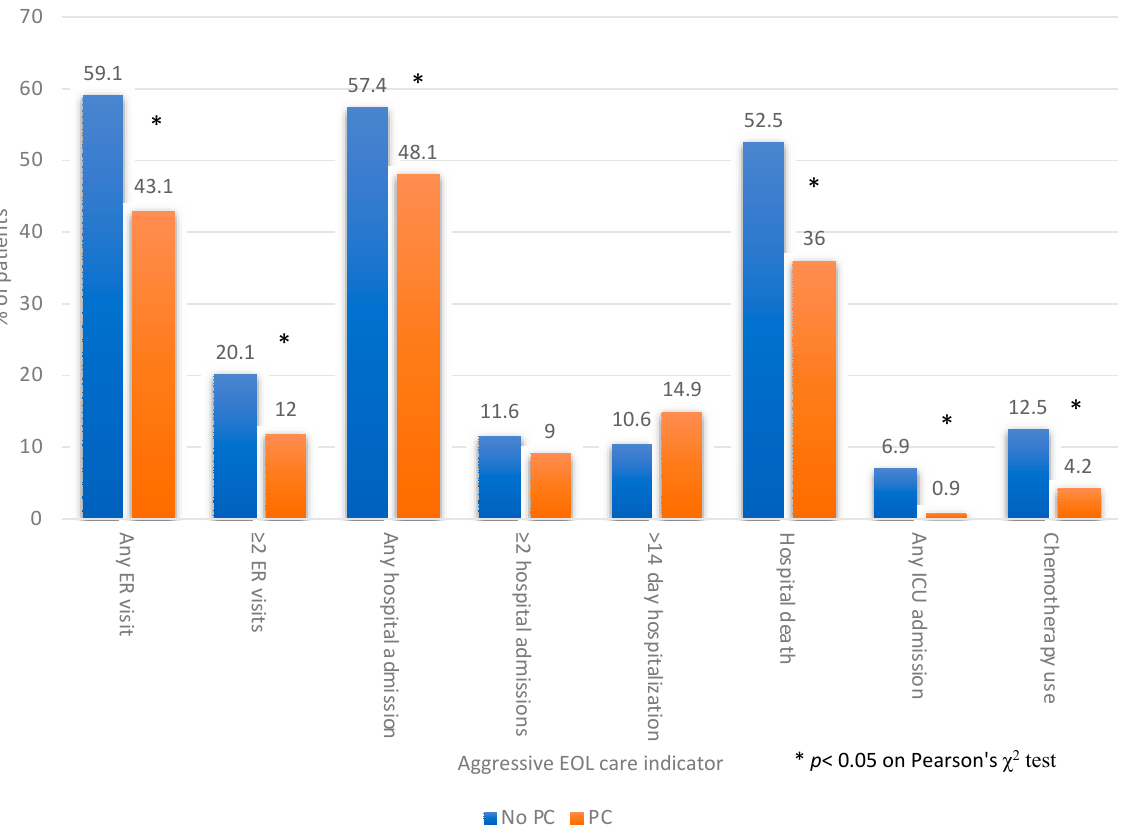
Figure 3. Proportions of composite scores for aggressive care at the end of life (EOL) (scale 0–6) [10], based on occurrence of palliative care consultation (Panel A = No; Panel B = Yes) ( N = 1414). Receiving palliative care consultation >3 months before death compared to receiving it ≤ 3 months before death was associated with lower proportions of patients with indica- tors of aggressive care at the EOL (Figure 4). These patients were less likely to visit an ER once (33.2% versus 48.3%, p < 0.001) or two or more times (9.2% versus 13.4%, p = 0.05).